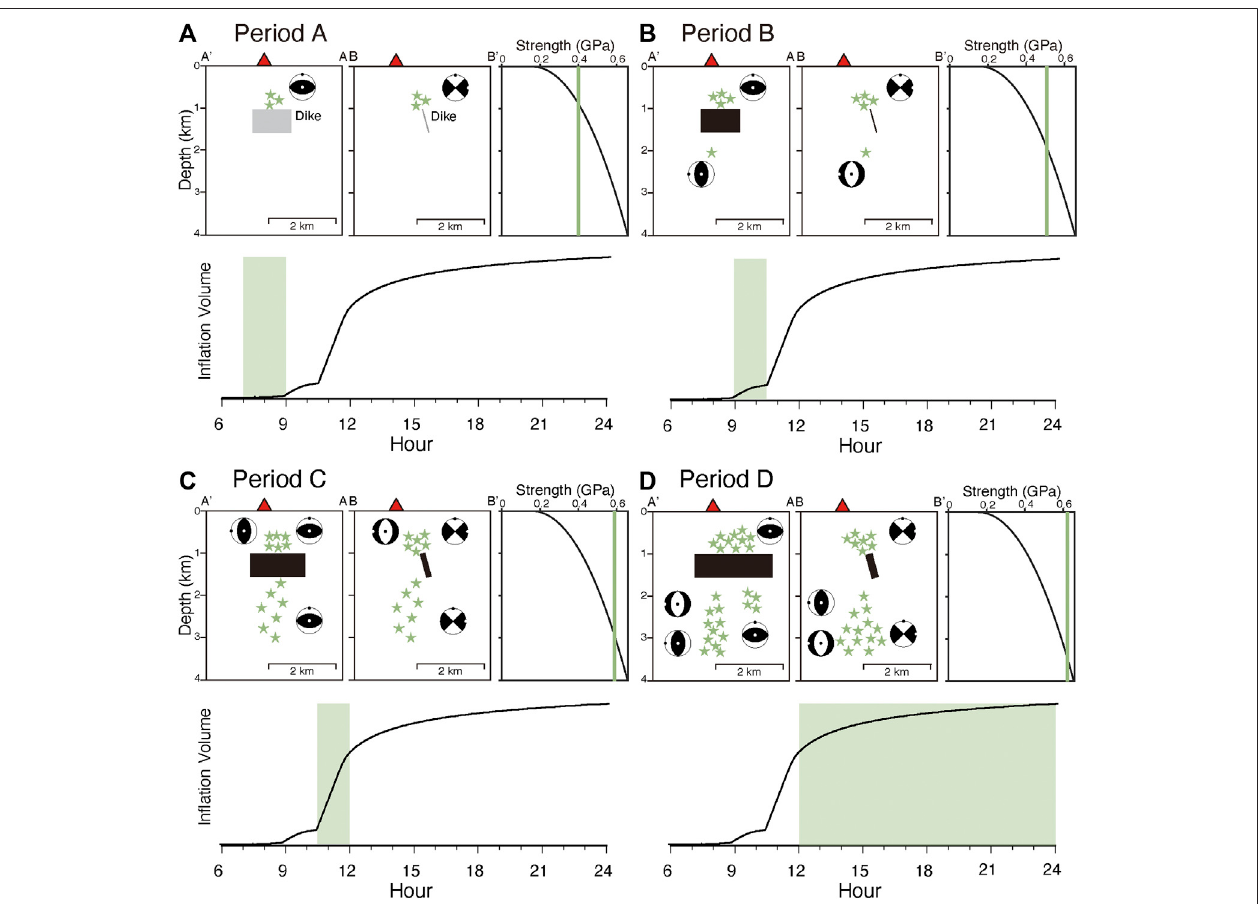
FIGURE15| Conceptualcross-sectionalA – A ′ and B – B ′ viewsofthehypocenterdistribution,locationofthedike,depthpro fi leofthebrittlefracturestrengthofthe crustalrocks,andconceptualdiagramoftheamountofthein fl ationofthedikeforthetimeperiods: (A) 7:00to9:00, (B) 9:00to10:30, (C) 10:30to12:00,and (D) 12:00 to 24:00 JST on August 15, 2015. Corresponding time period is shown with bright-green color. The location of the dike is shown by rectangles and lines in the cross- sections.Thegrayrectangleandlinesindicatetheinitialstageofthedikein fl ation,whileblackonesindicatetheevolutionstageofthedikein fl ation.Althoughthesize ofthedikerectangleissameforperiod Aand B,thegraydikerectangleexistsonly inperiodA,becausethein fl ationvolume ofthedikeinperiod Aissmaller thantheone in period B . Note that typical focal mechanisms (beach balls) are projected on the cross-sections for the four periods. The white and black dots show the position of T- and P-axes,